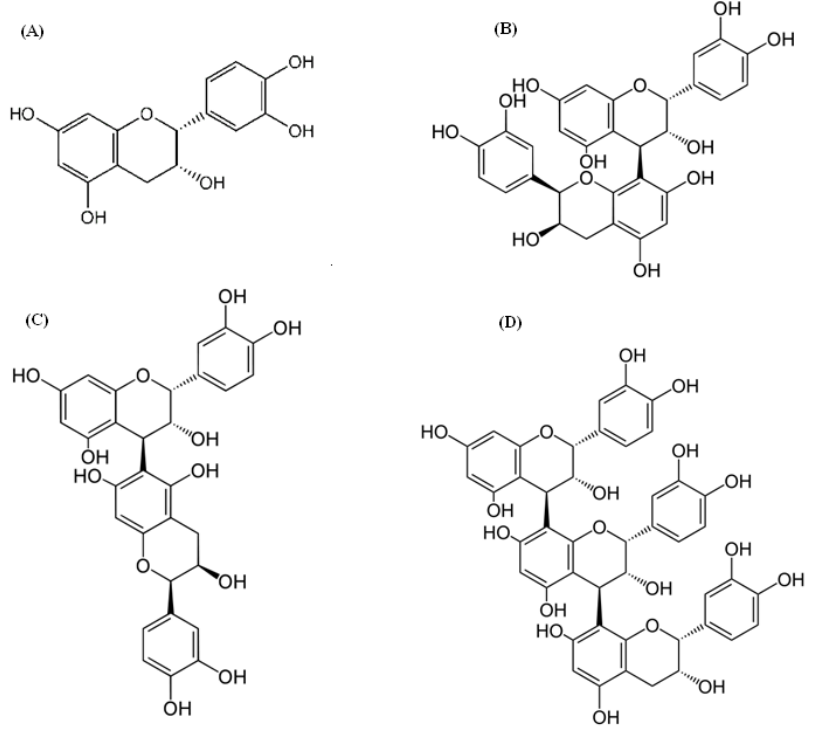
Figure 3. The most frequent procyanidin monomer ( A ) epicatechin dimers procyanidin B2 ( B ) and procyanidin B5 ( C ) and trimer procyanidin C1 ( D ) in Chinese hawthorn